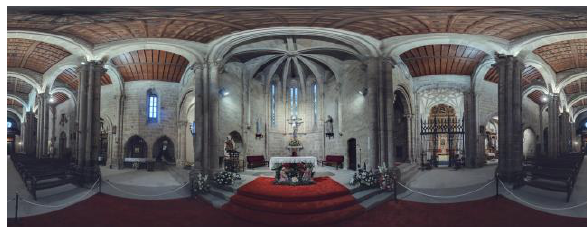
Figure 9. 360º image provided by ImmersiveStudio after processing iSTAR data.